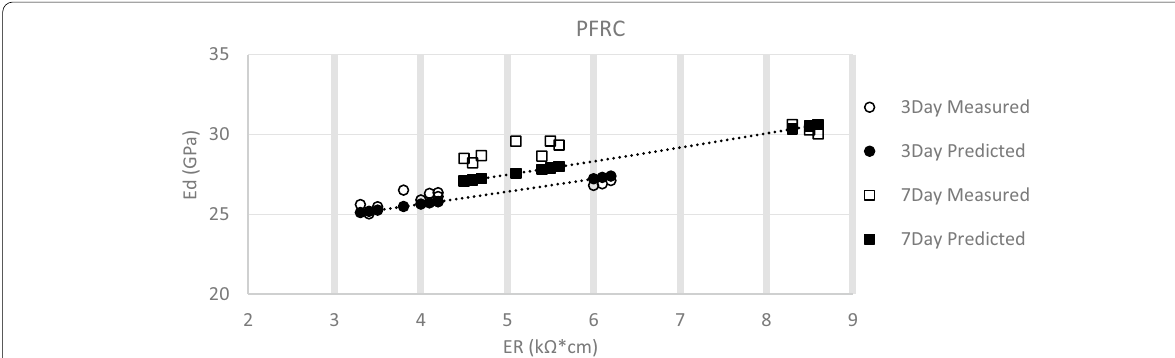
Fig. 3 Correlation between dynamic modulus and electrical resistivity for PFRC.